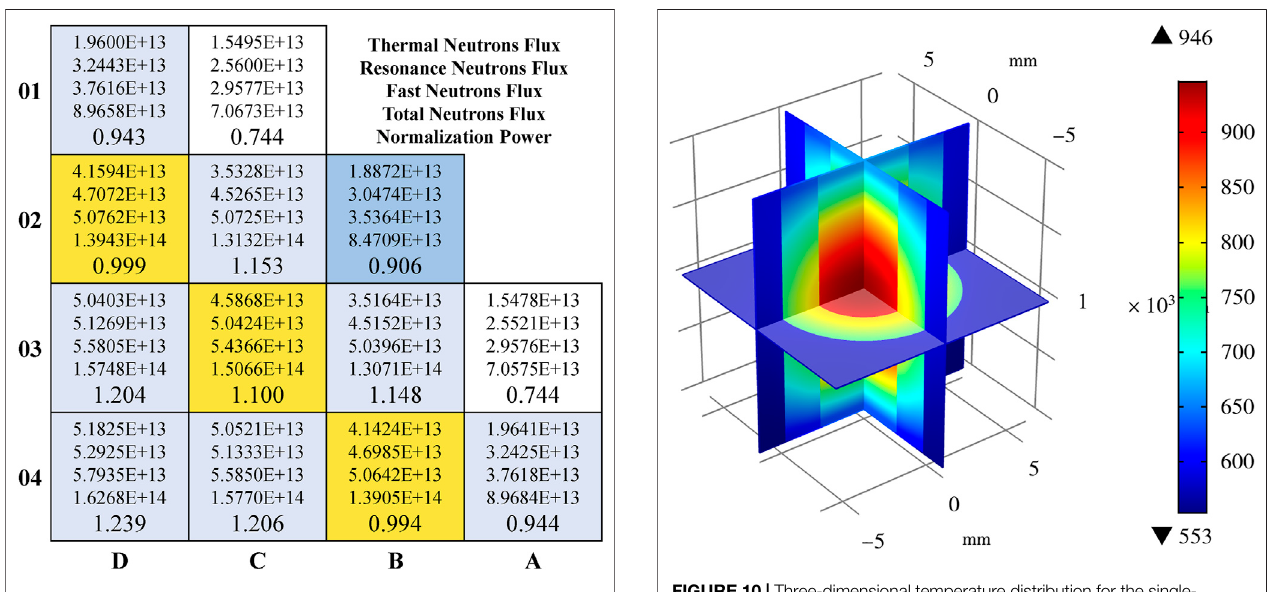
FIGURE 8 | Distributions of neutron fl uxes and normalization power in each FA.